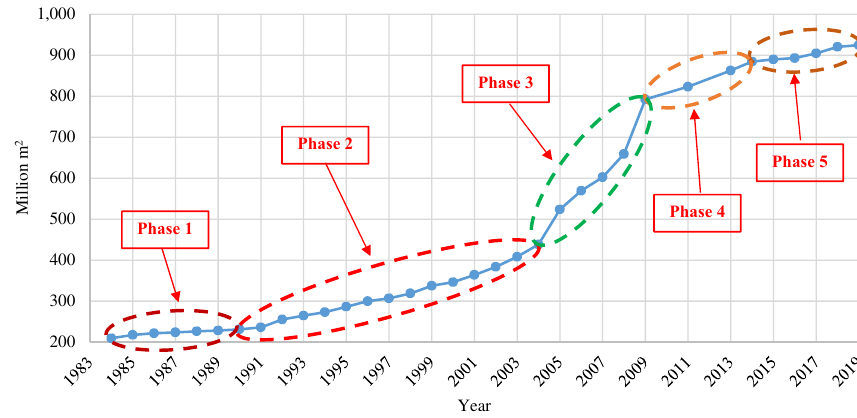
Fig. 1 Linear phases of the Built-up land use Evolution in Lebanon